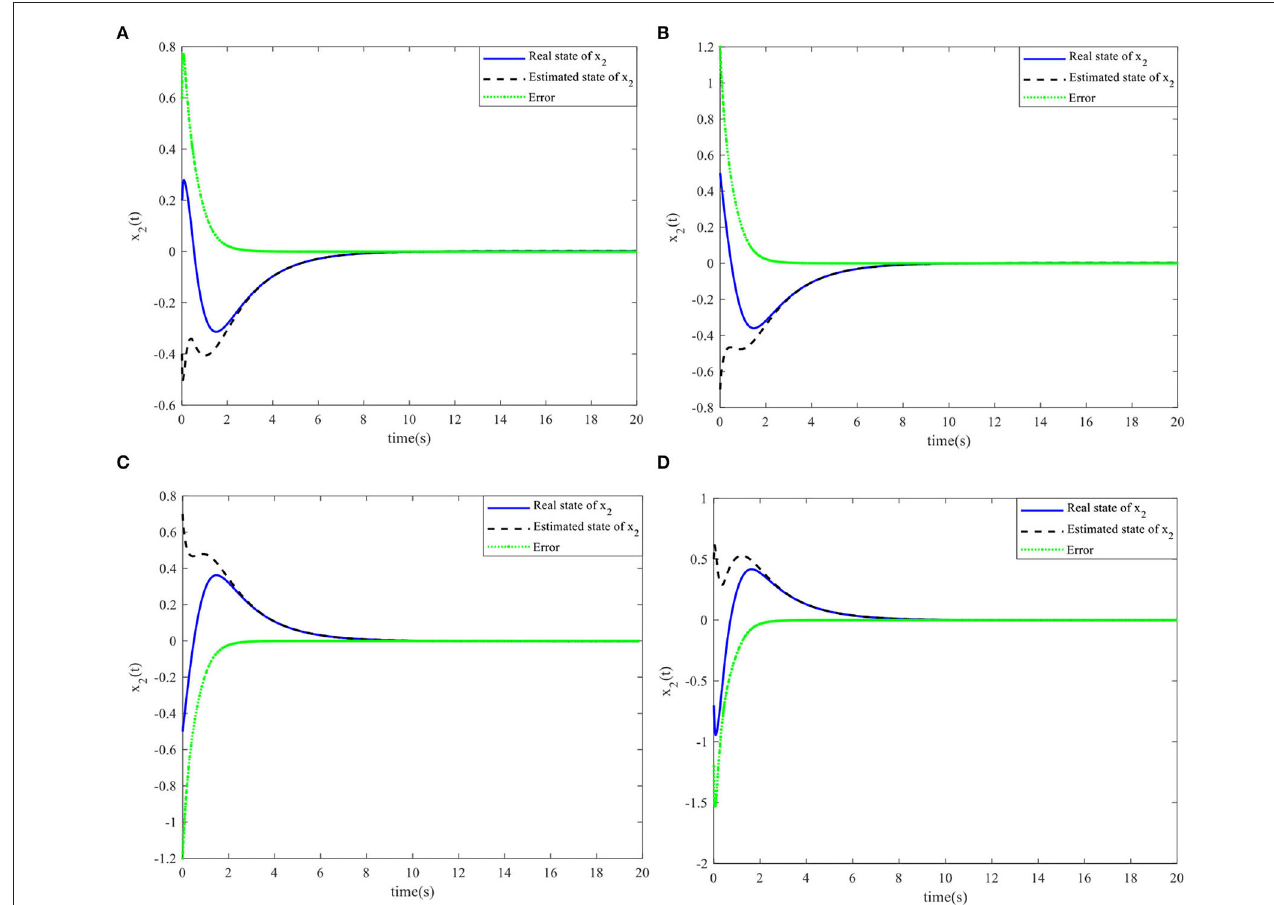
FIGURE 6 | Nonlinear state x 2 ( t ) and the estimated ˆ x 2 ( t ). (A) Initial simulation case 1. (B) Initial simulation case 2. (C) Initial simulation case 3. (D) Initial simulation case